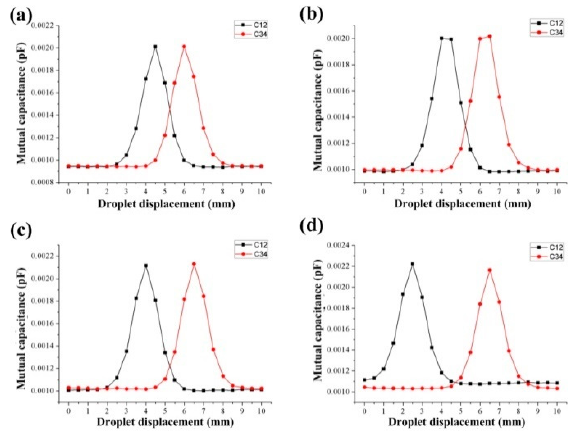
Figure 6. ( a – d ) The relationship between the distance of the adjacent capacitance electrodes and the position of the droplet.